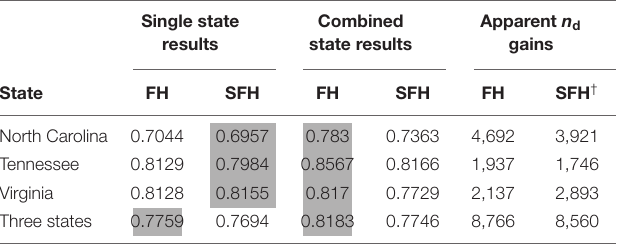
TABLE 4 | Mean standard error ratios (SER) of EBLUP RMSE to direct standard error, averaged over counties within state groupings.